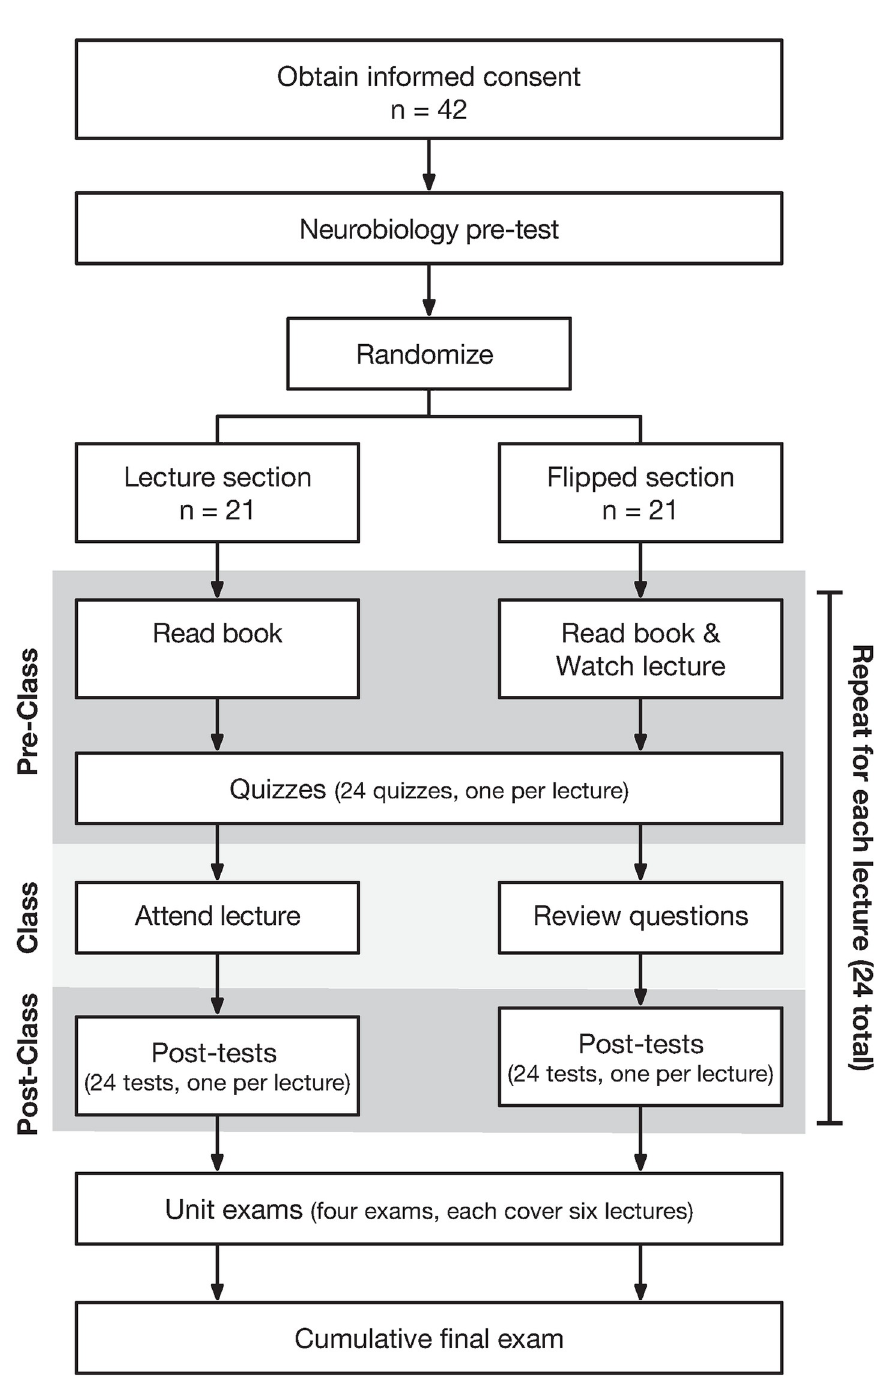
Fig 2. RCT experimental flow